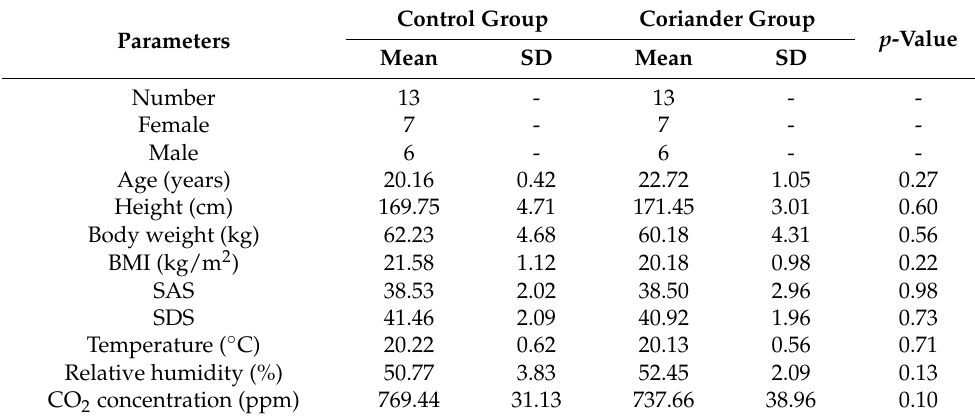
Table 1. Baseline measurements of participants ( n = 26) and environment quality of the experiment.